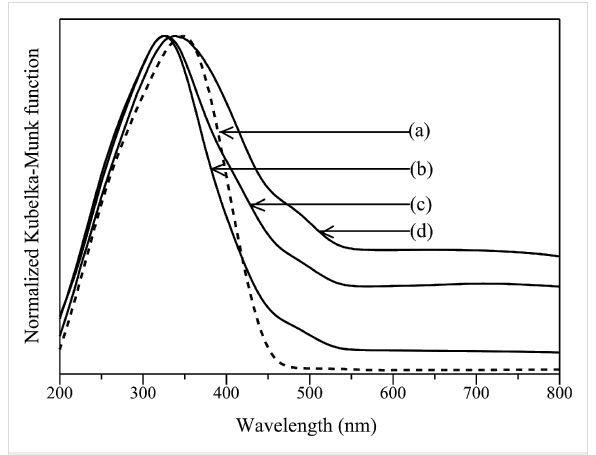
Figure 6: DR UV–visible spectra of (a) Cd 0.1 Zn 0.9 S, (b) Ag(0.01)- doped Cd 0.1 Zn 0.9 S, (c) Ag(0.03)-doped Cd 0.1 Zn 0.9 S (d) Ag(0.05)- doped Cd 0.1 Zn 0.9 S prepared by the co-precipitation